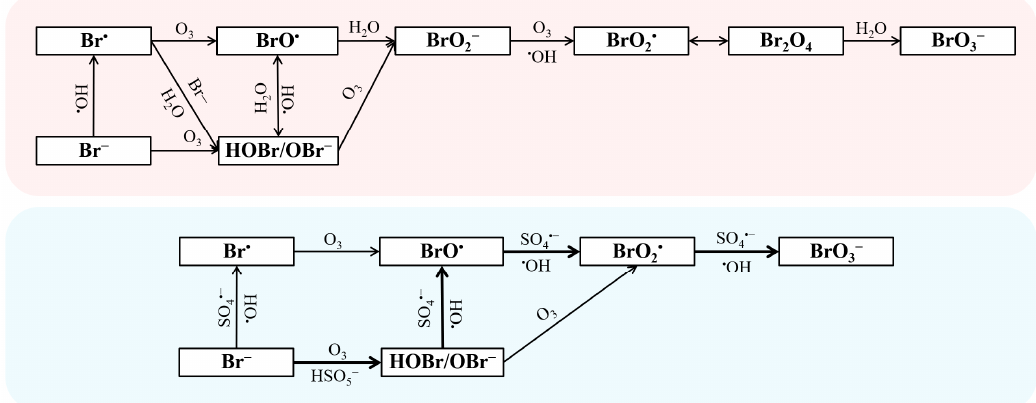
Figure 3. The mechanism of bromate formation (red: ozonation; blue: O 3 /PMS). Reprinted with permission of refs. [64,124].